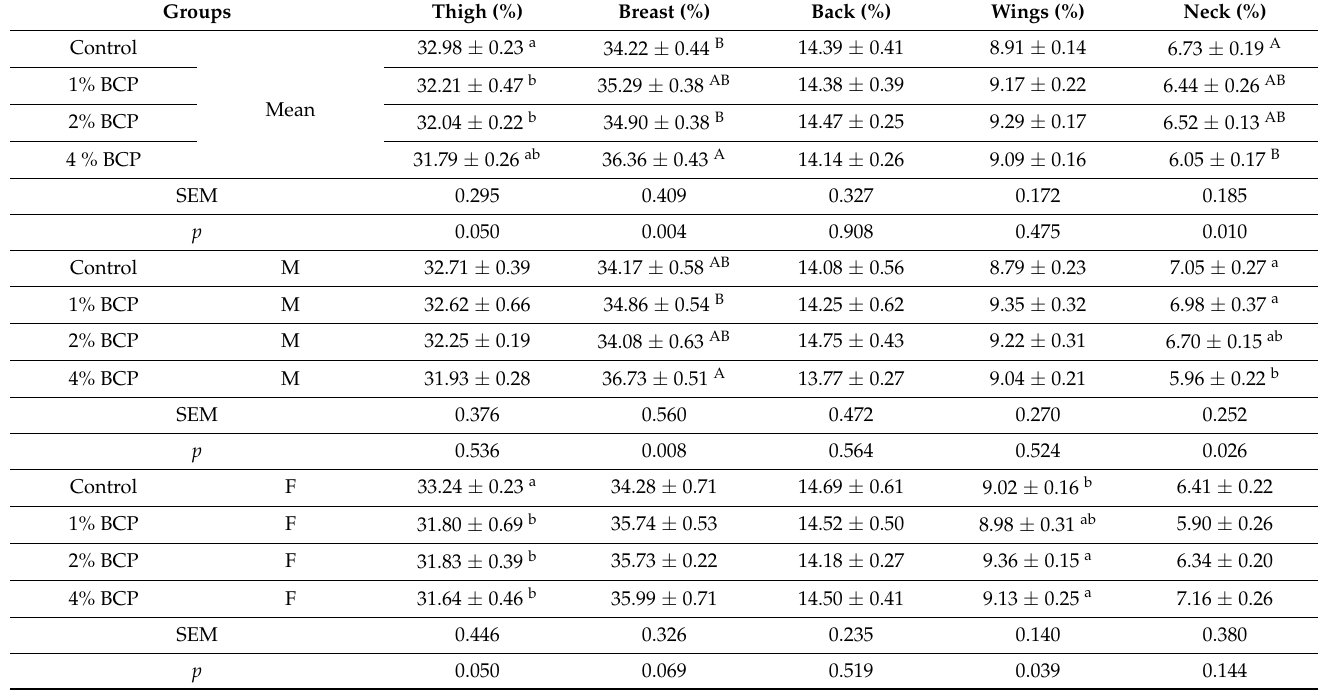
Table 4. The effect of the different levels of BCP supplementation on the commercial cut of the quail carcass (%).